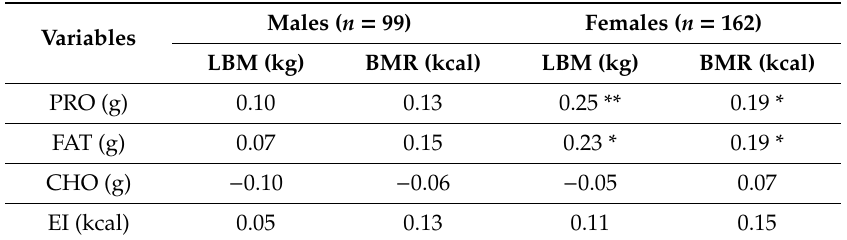
Table 4. Partial correlations between daily macronutrient intakes, LBM, and BMR of the study population a